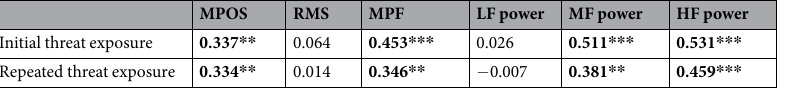
Table 4. Bivariate correlations between ankle muscle co-contraction and COP outcomes. Note . Variables reflect change scores (Initial threat exposure = HIGH1-LOW1; Repeated threat exposure = HIGH5- HIGH1). MPOS = mean position of centre of pressure; RMS = root mean square of centre of pressure; MPF = mean power frequency of centre of pressure; LF power = low frequency centre of pressure power; MF power = medium frequency centre of pressure power; HF power = high frequency centre of pressure